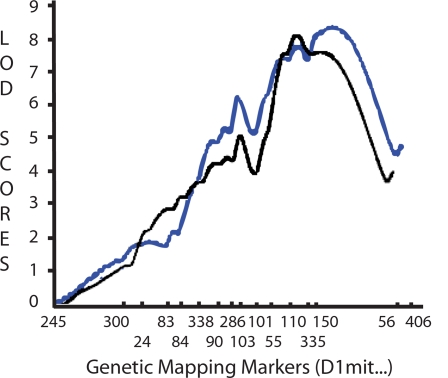
LOD Scores for Markers along Chromosome 1.LOD scores are shown for fasting blood glucose (black) and pancreatic grade (blue). Terminal phenotypes by genotype at D1Mit110 at 169.6 Mb are summarized in Table S5.